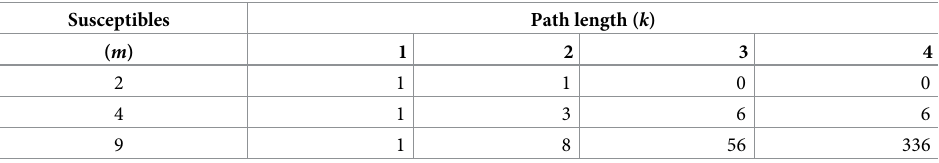
Table 1. Number of paths from the primary case to a given susceptible.